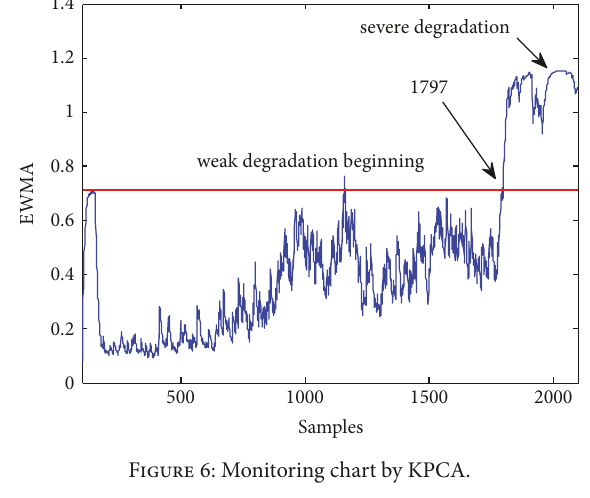
Figure 6: Monitoring chart by KPCA.